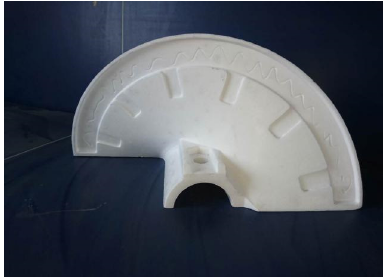
Figure 2. EPS model.